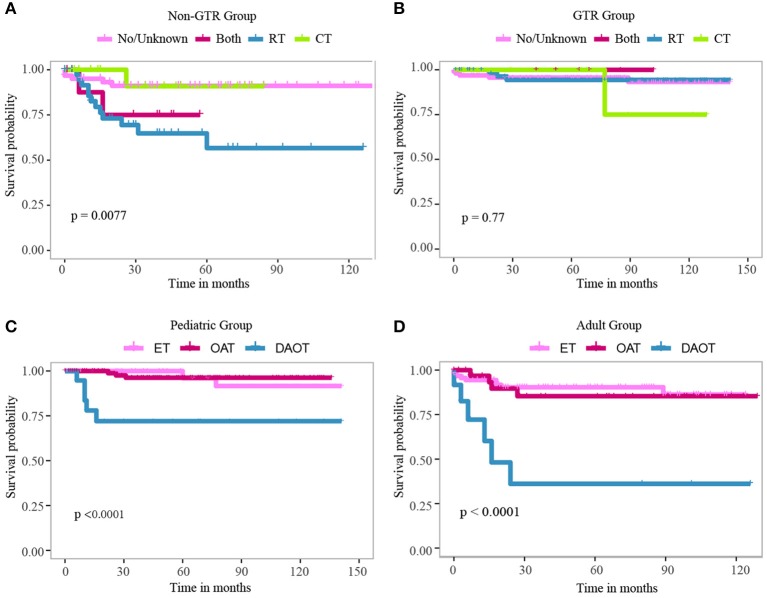
Kaplan–Meier curve for patients with LGBSG in non-GTR group (A) and GTR group (B) treated with different adjuvant therapies. Kaplan–Meier curve for pediatric patients (C) and adult patients (D) with different histology types.